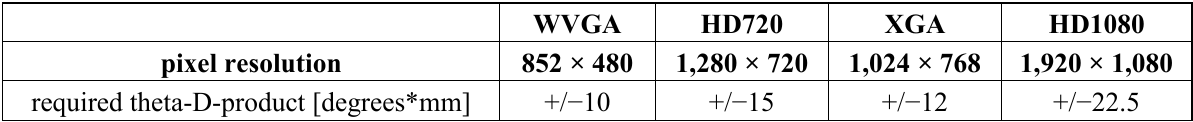
Table 2. MEMS oscillation amplitude requirements in a laser projection display